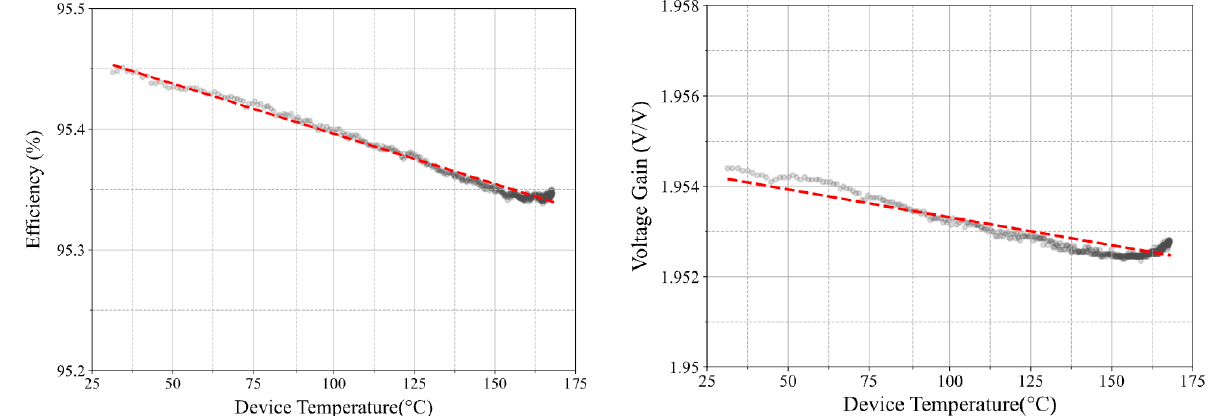
Table 3. The temperature of measurement points and results for P out = 700 W.